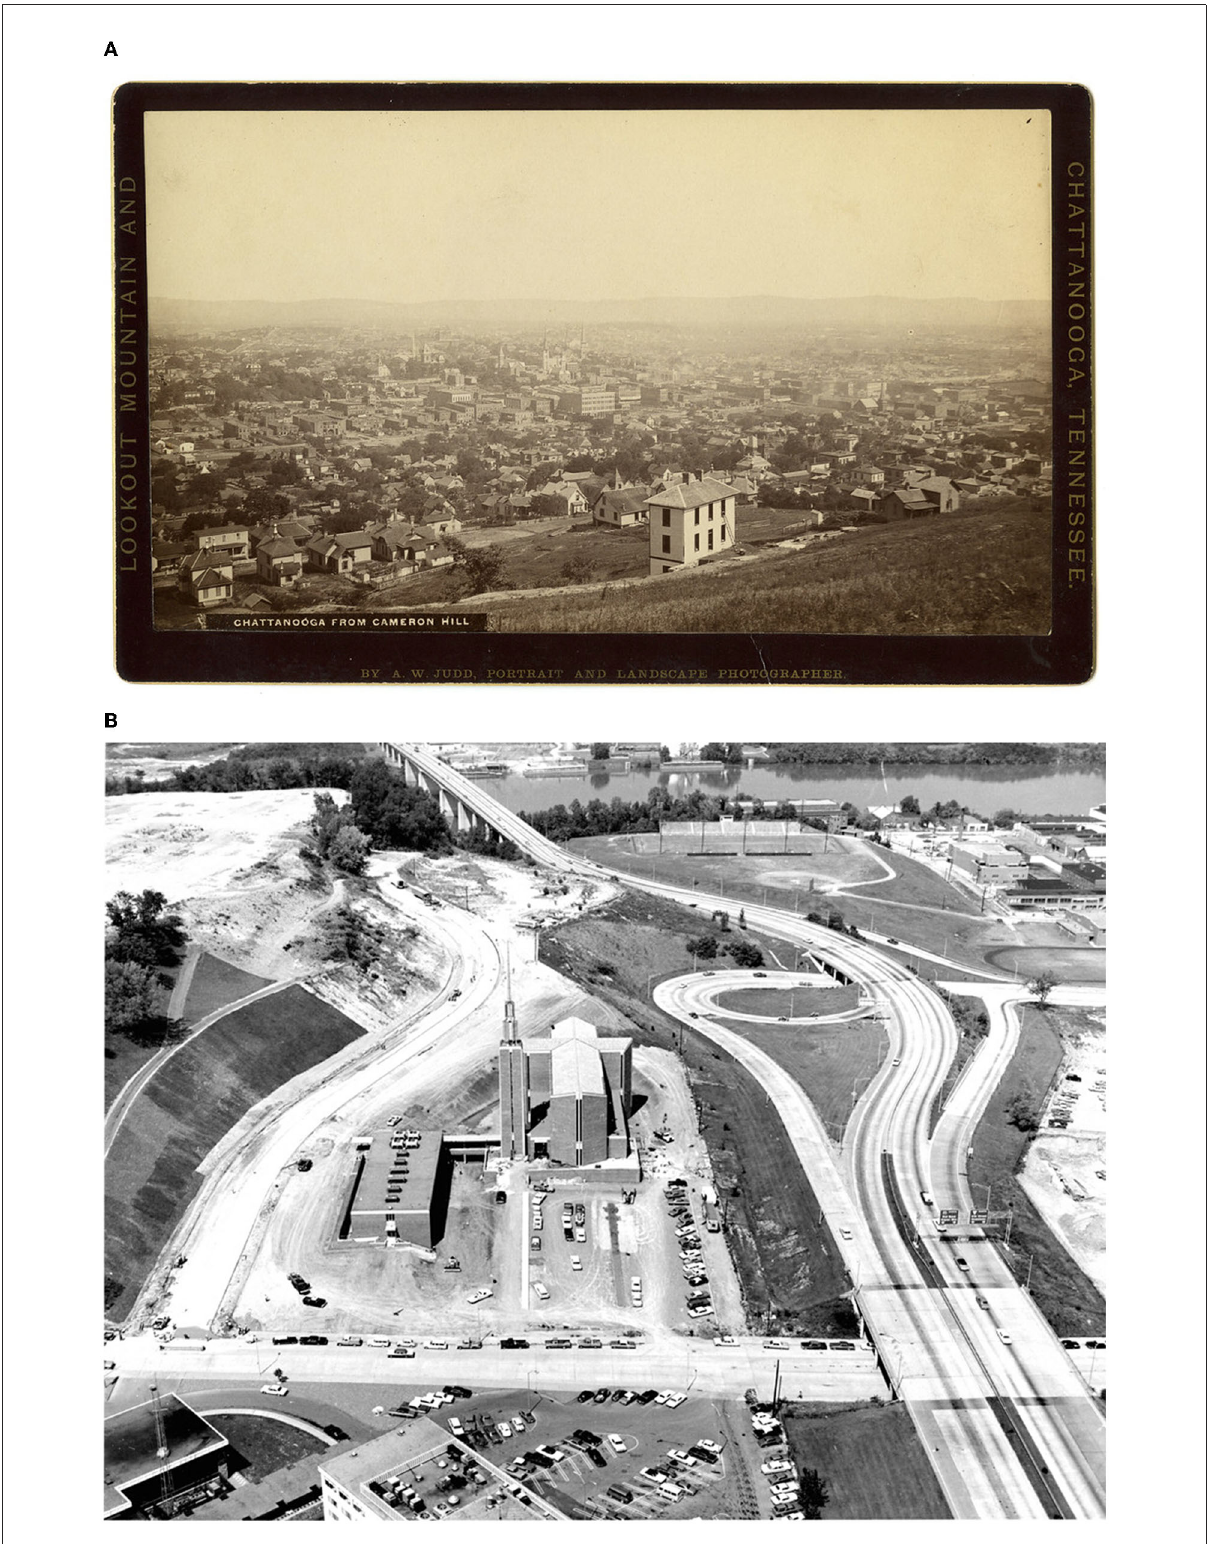
FIGURE1 (A) Cameron Hill before urban renewal. (B) Cameron Hill after urban